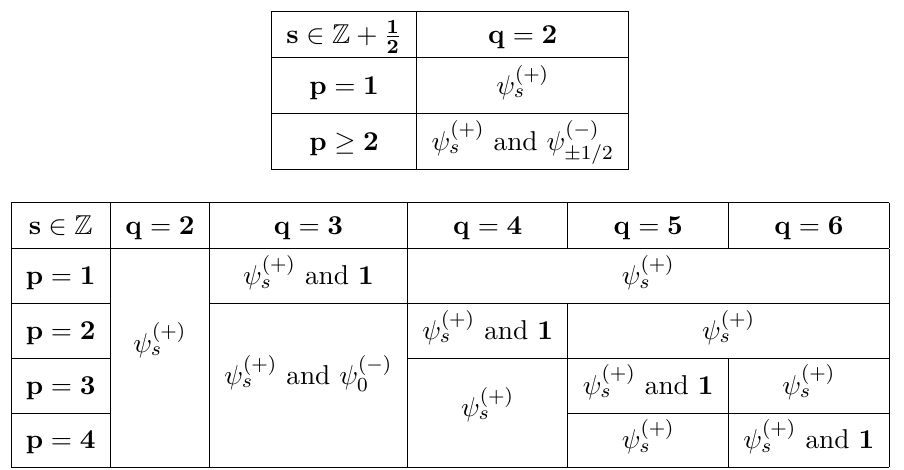
Table 1 . Table of unitary defect spectrum in the free theory: for monodromy defects with q = 2 and half-integer s on the top, and for general non-monodromy defects on the bottom. The pattern in the bottom table continues outside the shown range of p and q . For q > 2 the listed operators transform as symmetric traceless SO( q ) tensors and then s corresponds to its